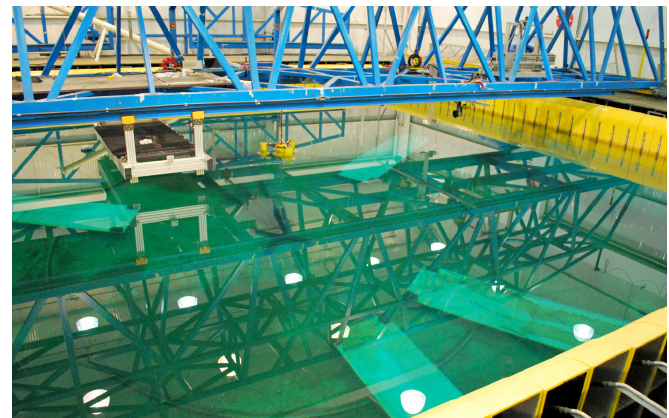
Figure 3. TPNwave